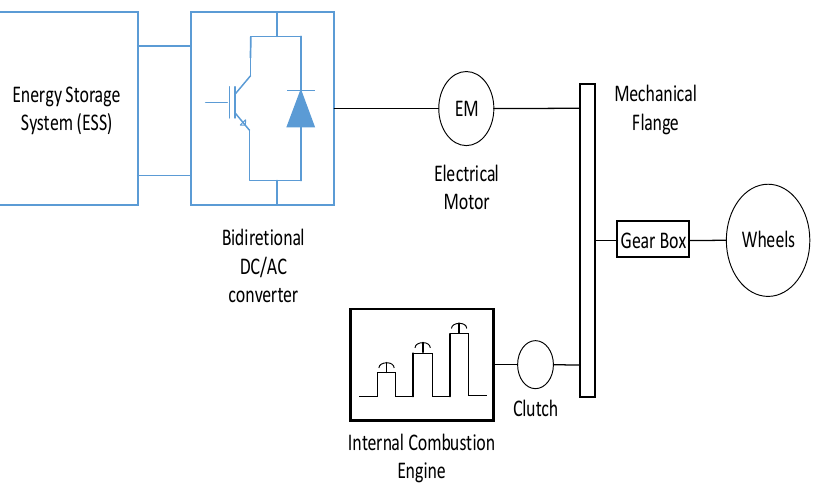
Figure 4. Parallel hybrid diesel–electric traction system [36].